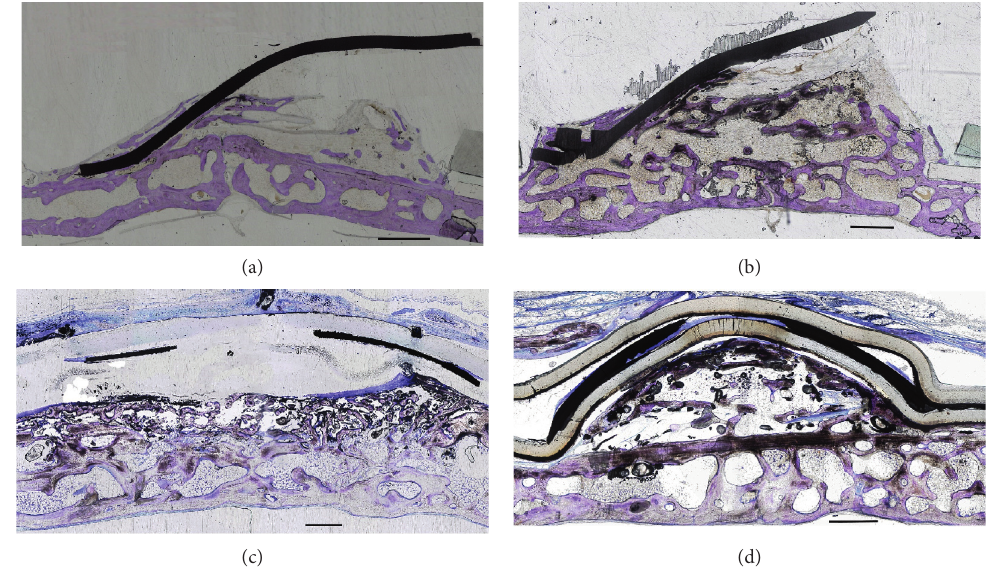
Figure 5: Histological longitudinal sections of the calvaria with toluidine blue staining of the original bone and newly created space after device insertion. (a) Expansible guided bone regeneration (EGBR) device, 2-month group; the new space is occupied by newly generated bone with a space on the top. (b) EGBR device, 4-month group. (c) Smart guided bone regeneration (SGBR) device, 2-month group; the new space is partially occupied by newly-generated bone with a space on the top. (d) SGBR device, 4-month group; more bone formation is visible than in the 2-month group. Scale bar �